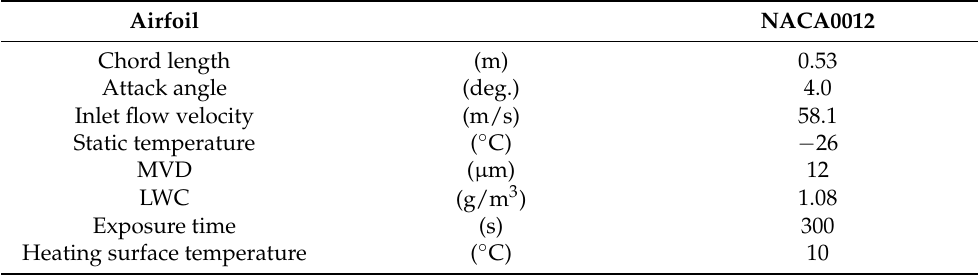
Table 2. Numerical conditions for the NACA0012 airfoil (Olsen et al.